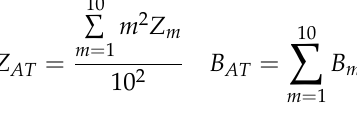
( b ) Figure 7. Aggregated model of the 108 MW wind power plant shown in Figure 8, ( a ) aggregated model on each string as one 36 MW wind turbine, ( b ) aggregated model of three strings into one 108 MW wind turbine.